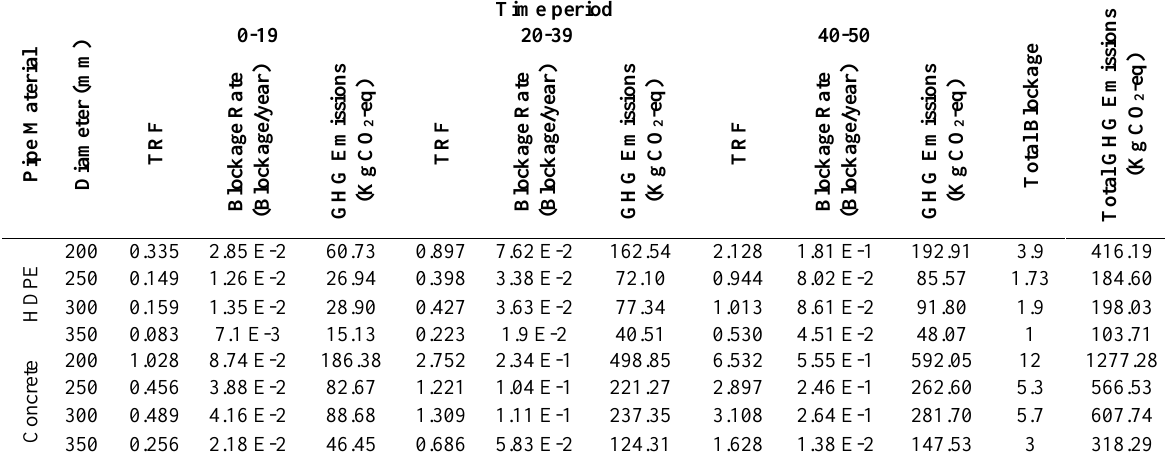
Table 2. GHG emissions in the cleaning operation period for 1 km wastewater pipe